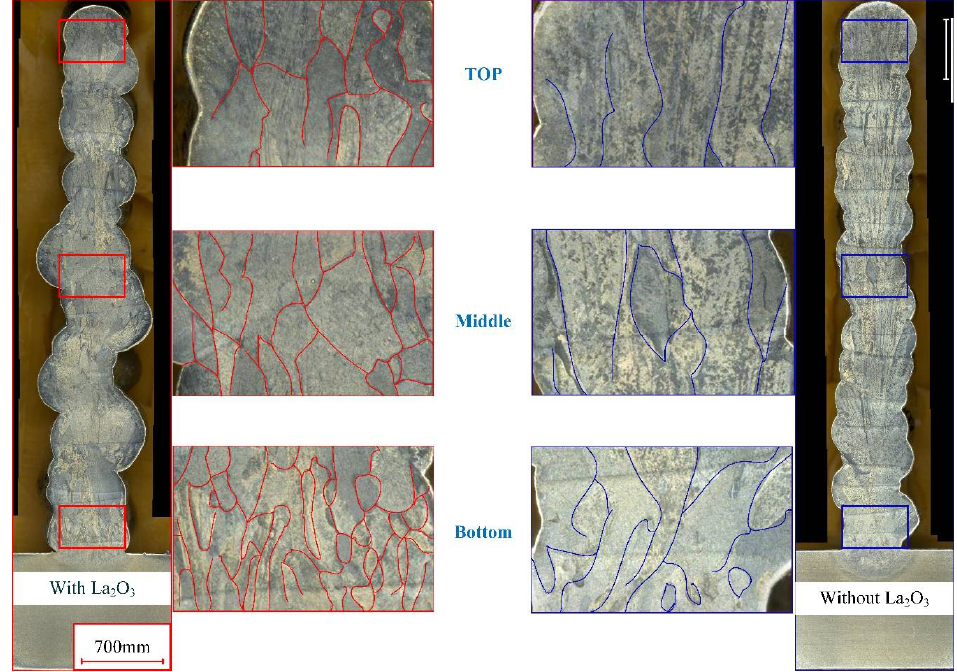
Figure 2. Cross-section of thin-walled parts with and without La 2 O 3.